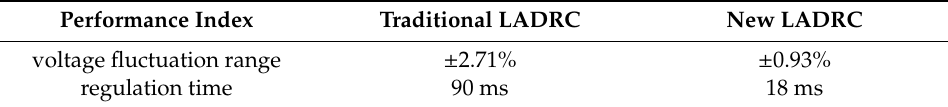
Table 2. Performance index comparison for the grid side voltage dropping to 85% case.